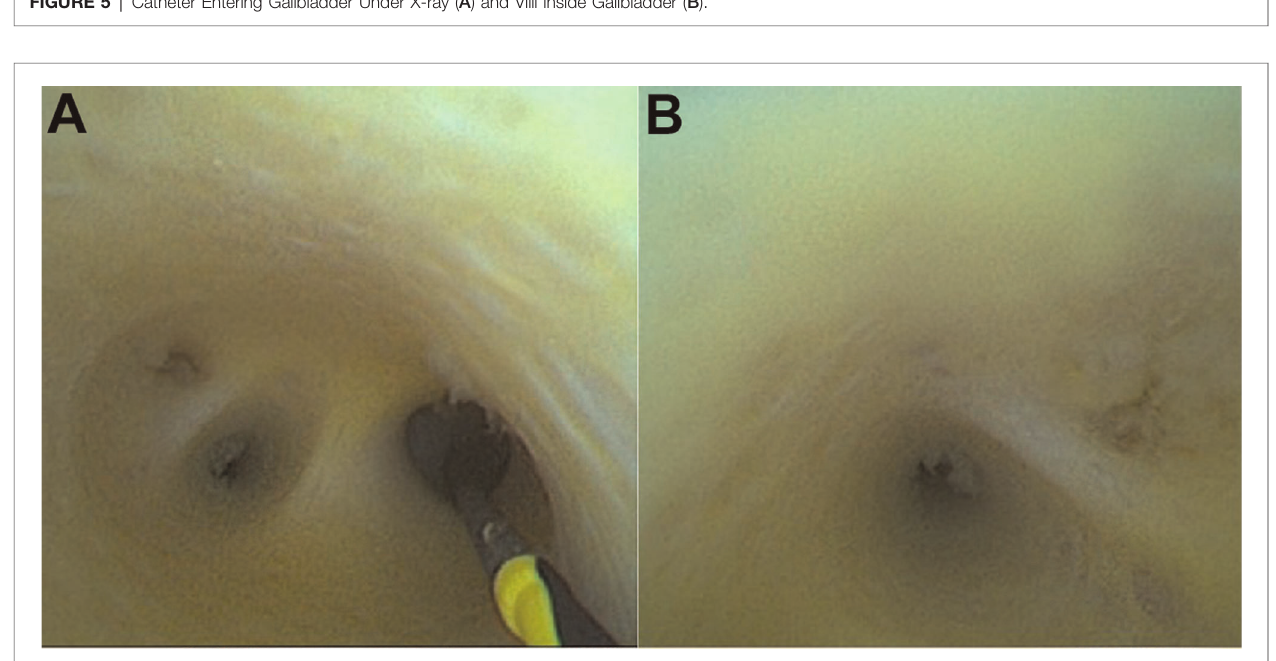
FIGURE 5 | Catheter Entering Gallbladder Under X-ray ( A ) and Villi inside Gallbladder ( B ).